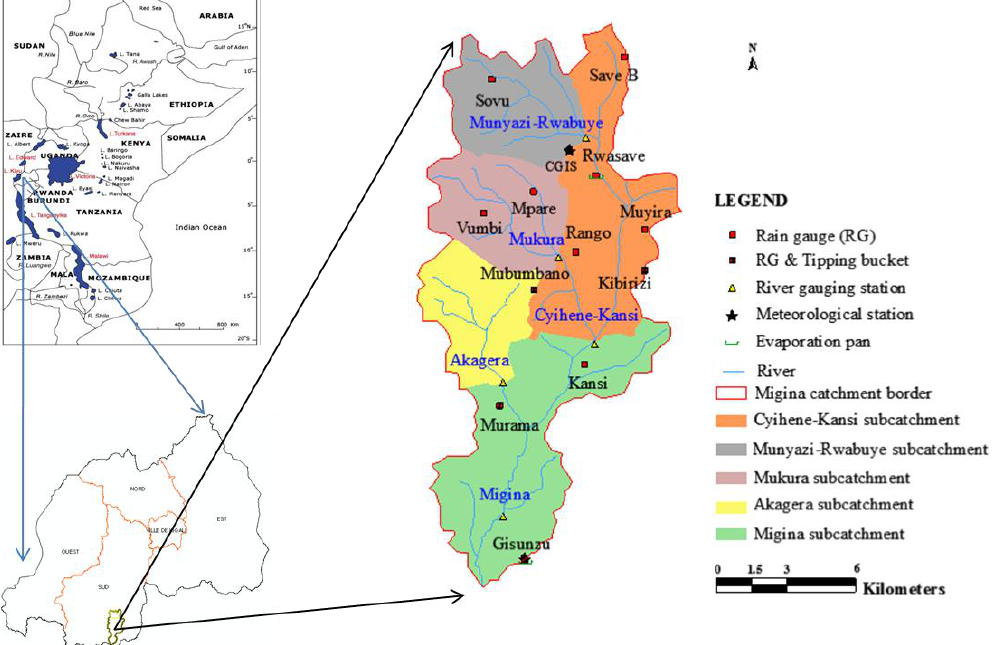
Figure 1 Location of the Migina catchment in Rwanda and East Africa, and instrumentation set-up within this research project showing the positions of Kansi and Migina gauging stations. topography. The site is mountainous with elevations